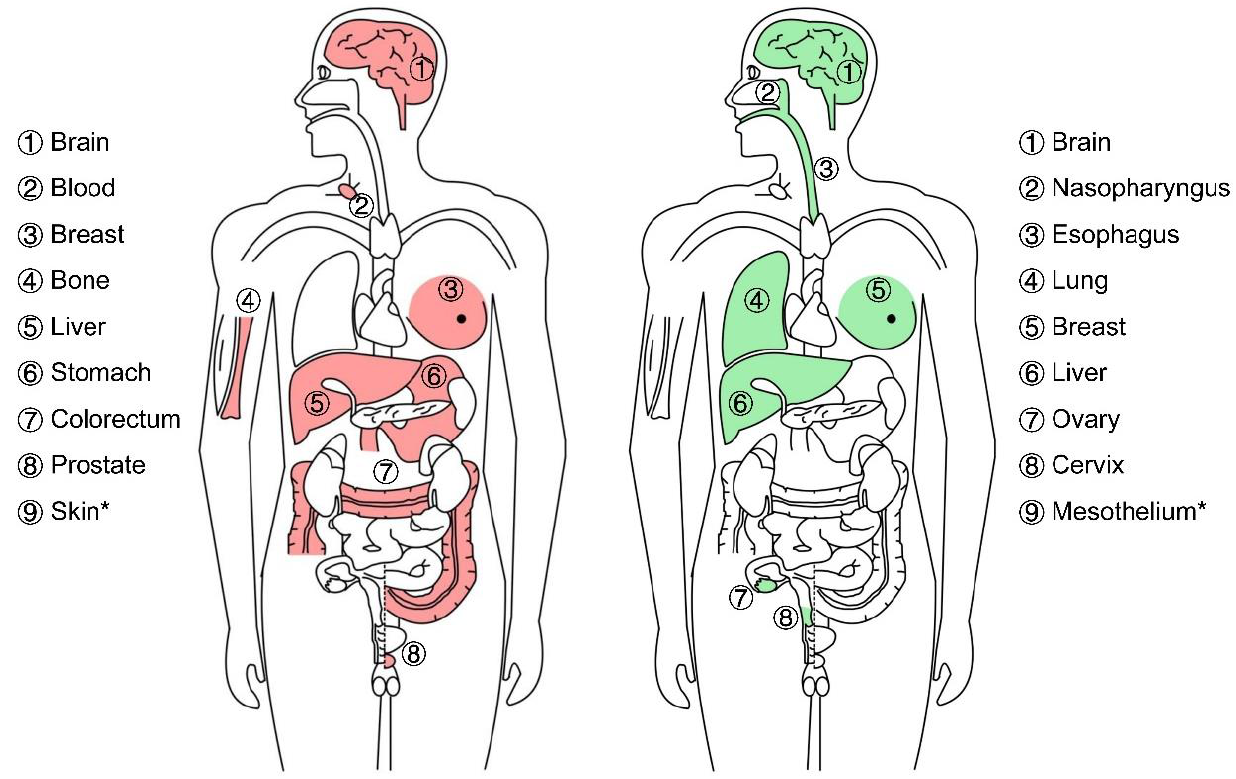
Figure 2. Dual role of RRAD in specific cancer types. Red represents oncogene effect of RRAD, whereas green represents tumor suppressor effect. Cancers with * are not represented in the figure. Detailed explanations are summarized in Tables 1 and 2. Table 1. Tumor suppressor effect of RRAD.